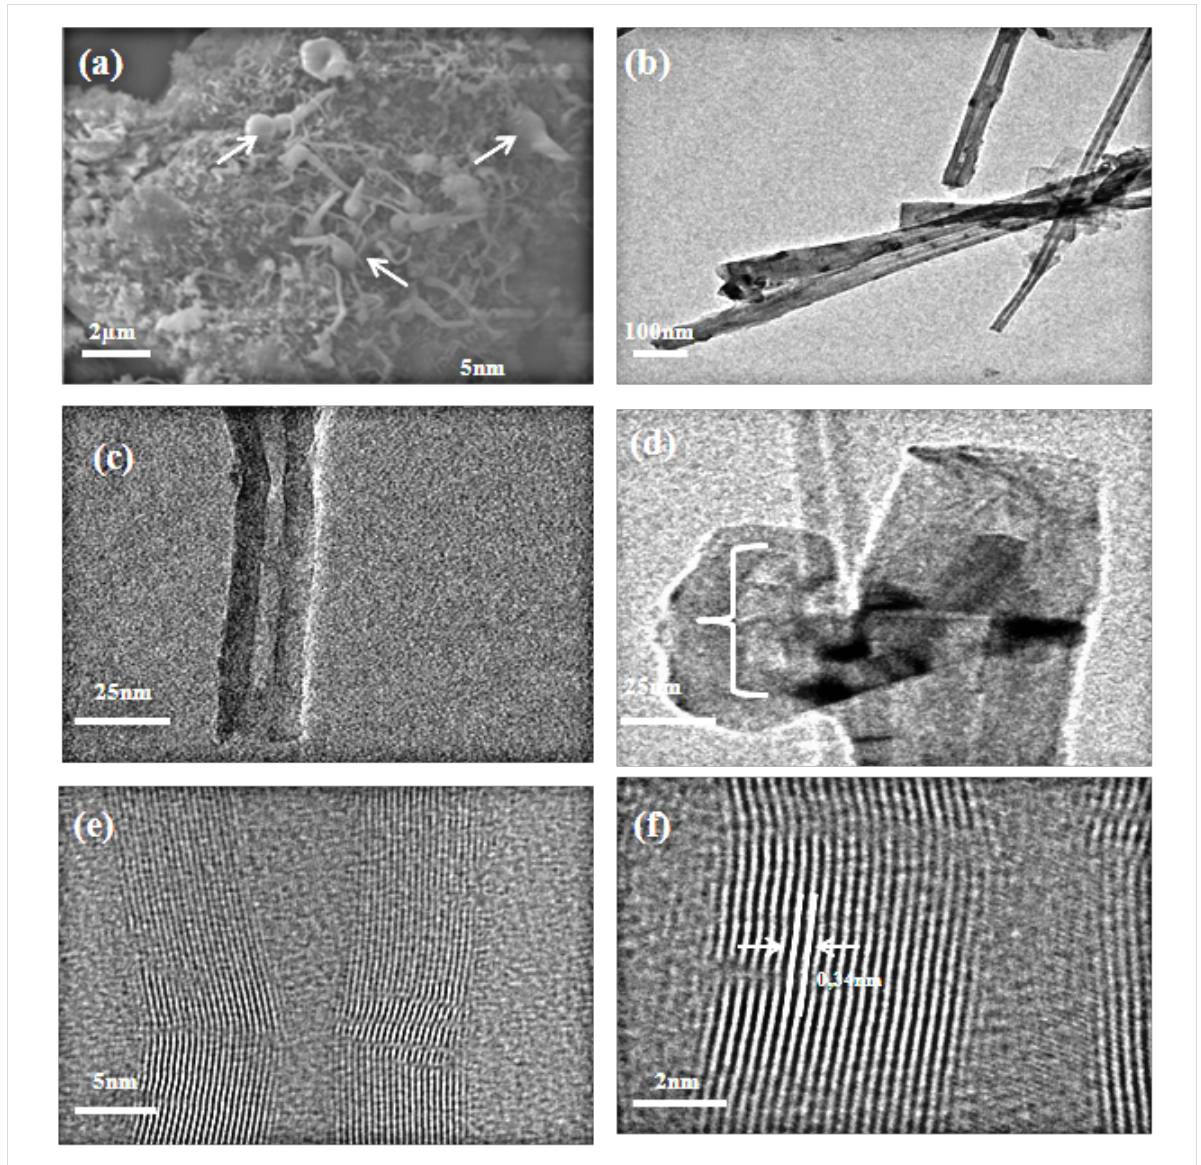
Figure 3: TEM and HRTEM images of BNNTs. (a) SEM image of initial compounds of BNNTs synthesized according to the base growth mechanism (White arrows show initially formed Fe–BN complexes), (b) and (c) TEM image of an open-ended BNNT, (d) TEM image of BNNT with bamboo-like structure, (e) and (f) High resolution TEM images of